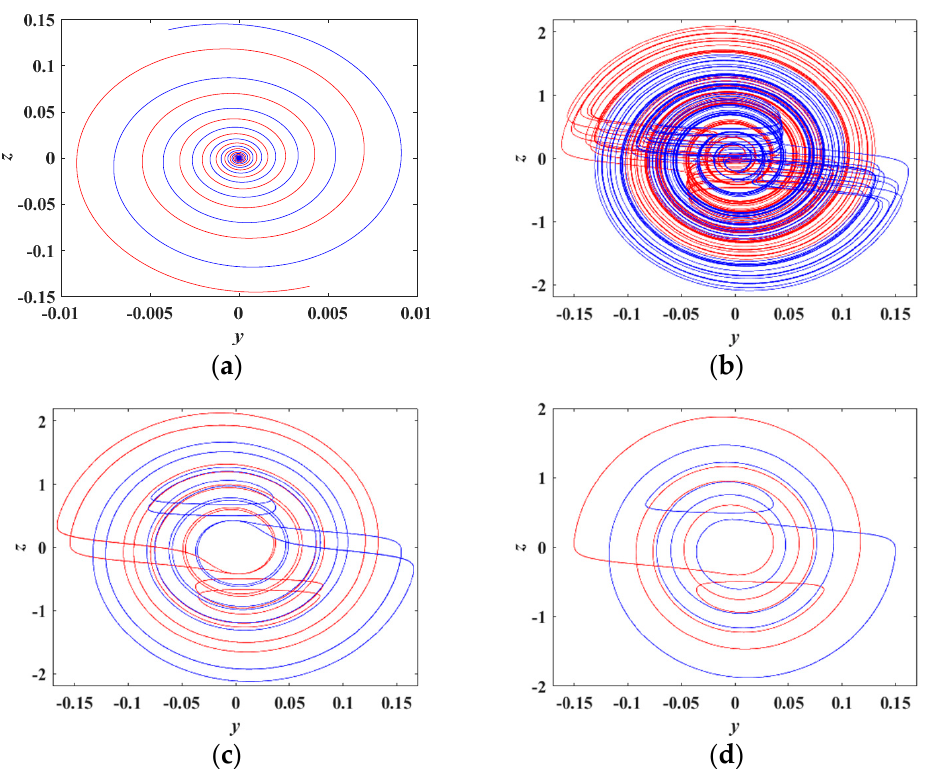
Figure 12. Evolution of coexisting attractors with the varying parameter a : ( a ) a = 7.38; ( b ) a = 7.5; ( c ) a = 8.0; ( d ) a = 8.2.